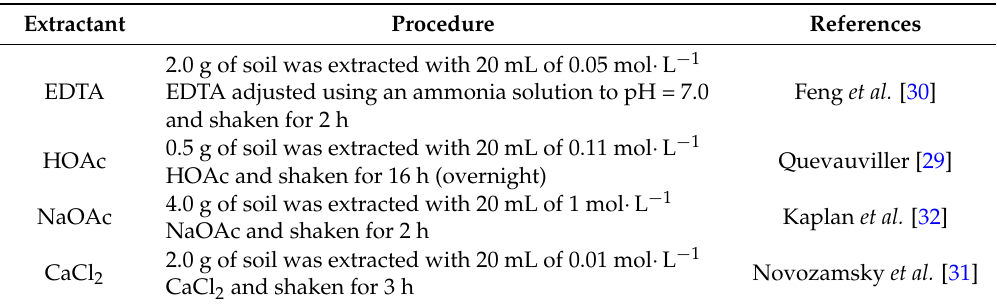
Table 1. Determination of Cd in